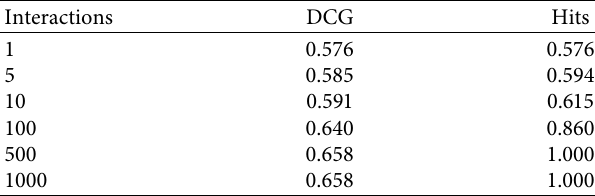
Table 2: Metrics DCG and Hits for Scenario 1.